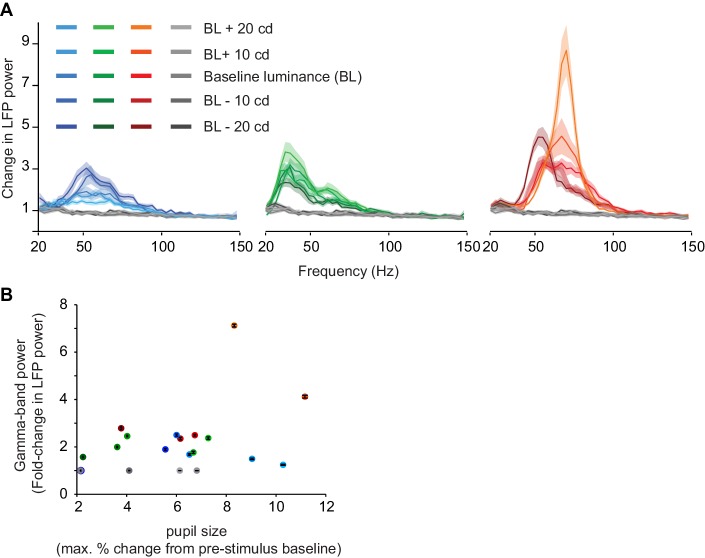
Dependence of gamma LFP power on the surface hue: control experiment for luminance-contrast.(A) Single session from monkey H with luminance match between achromatic and chromatic surface stimuli. Each color, including gray, was shown at five luminance levels, namely equiluminant to the background grey, or in two steps of 10 cd/m2 brighter or darker than the background. Blue and red hues at higher luminances were obtained by adding luminance from the green channel to maximal blue or red output, respectively. Note that achromatic responses are weaker than chromatic responses also in this luminance-matched case. (B) Dependence of gamma-band power on pupil responses. Pupil responses represent the maximal percent change from baseline during the stimulus period. The correlation over all hues was not significant (r = 0.38, p=0.1). Note that gamma responses for achromatic stimuli were poor regardless of the degree of pupil change.